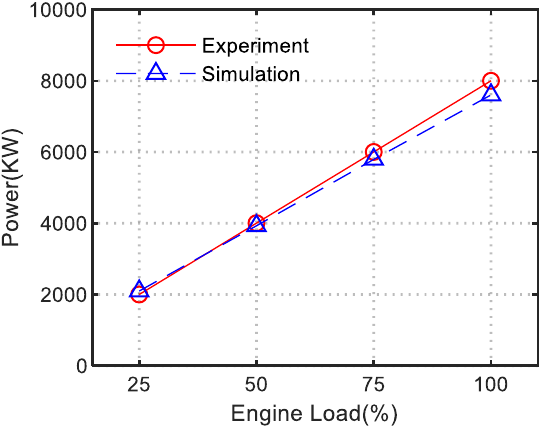
Figure 8. Power comparison between simulation and experiment.